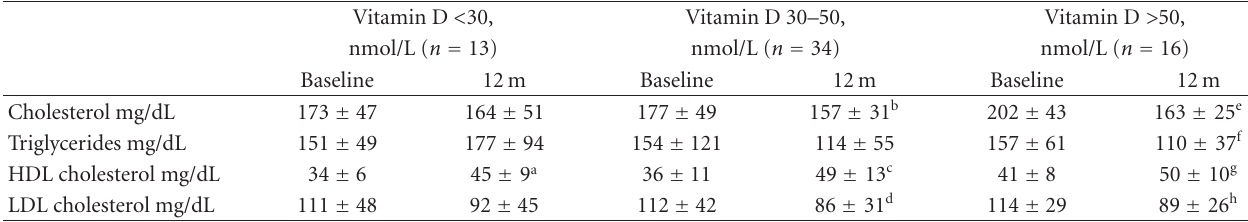
Table 2: Vitamin D levels and response to